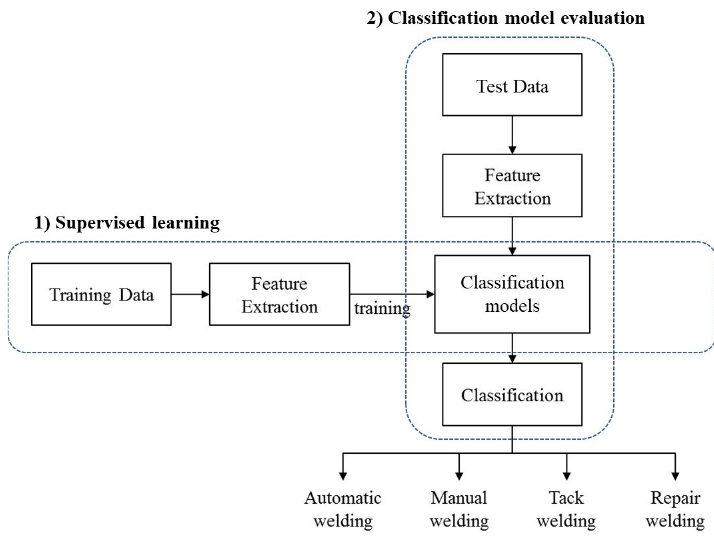
Figure 16. Experimental structure of welding type classification